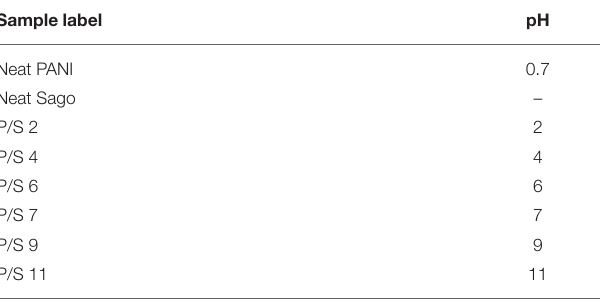
Frontiers in Materials |